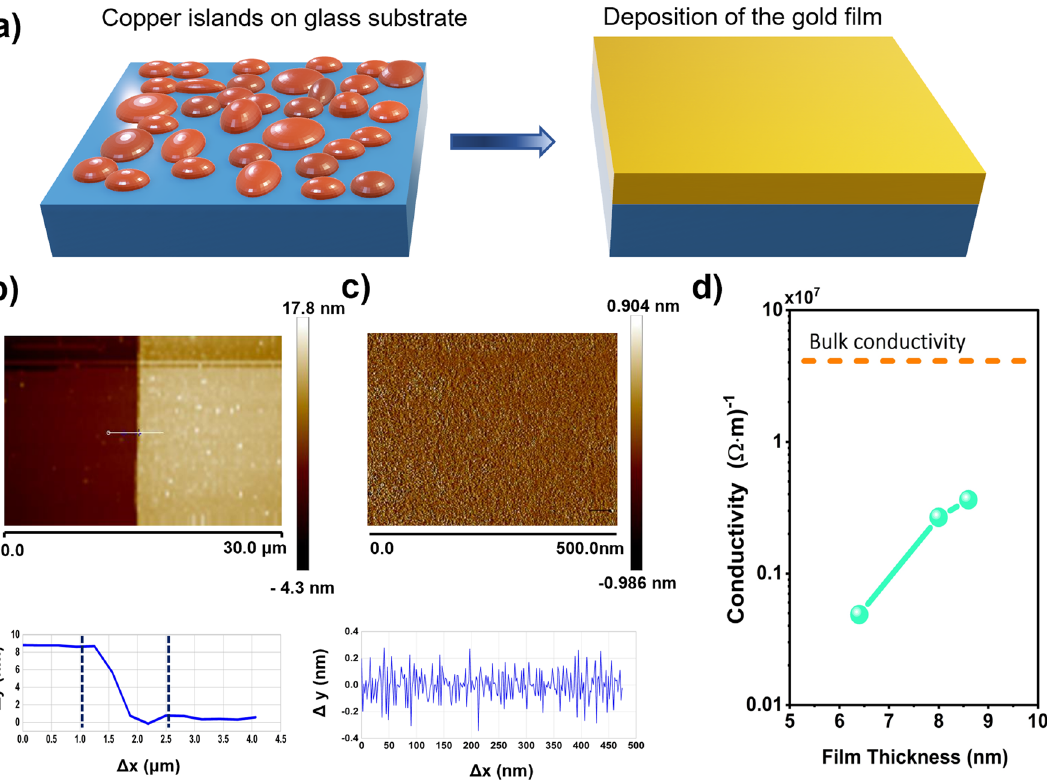
Figure 3. (a) Schematic diagram of the fabrication of the uniform ultra-thin film gold on top of the glass substrate. (b) AFM image of a step with 7.98 nm thickness, fabricated of mass-equivalent thickness h = 6.5 nm grown on 130 μm glass substrates, with a copper seed layer about 1 nm. (c) Surface morphology of the seeded gold with the roughness about 0.2 nm shows continuous and relatively smooth films. (d) D.C. conductivity for different thicknesses of film, measured by four probe technique (the axis of the conductivity is in the log scale 7 (� m ) − 1 and dashed yellow line shows bulk conductivity of thick gold film ( 4.1 × 10